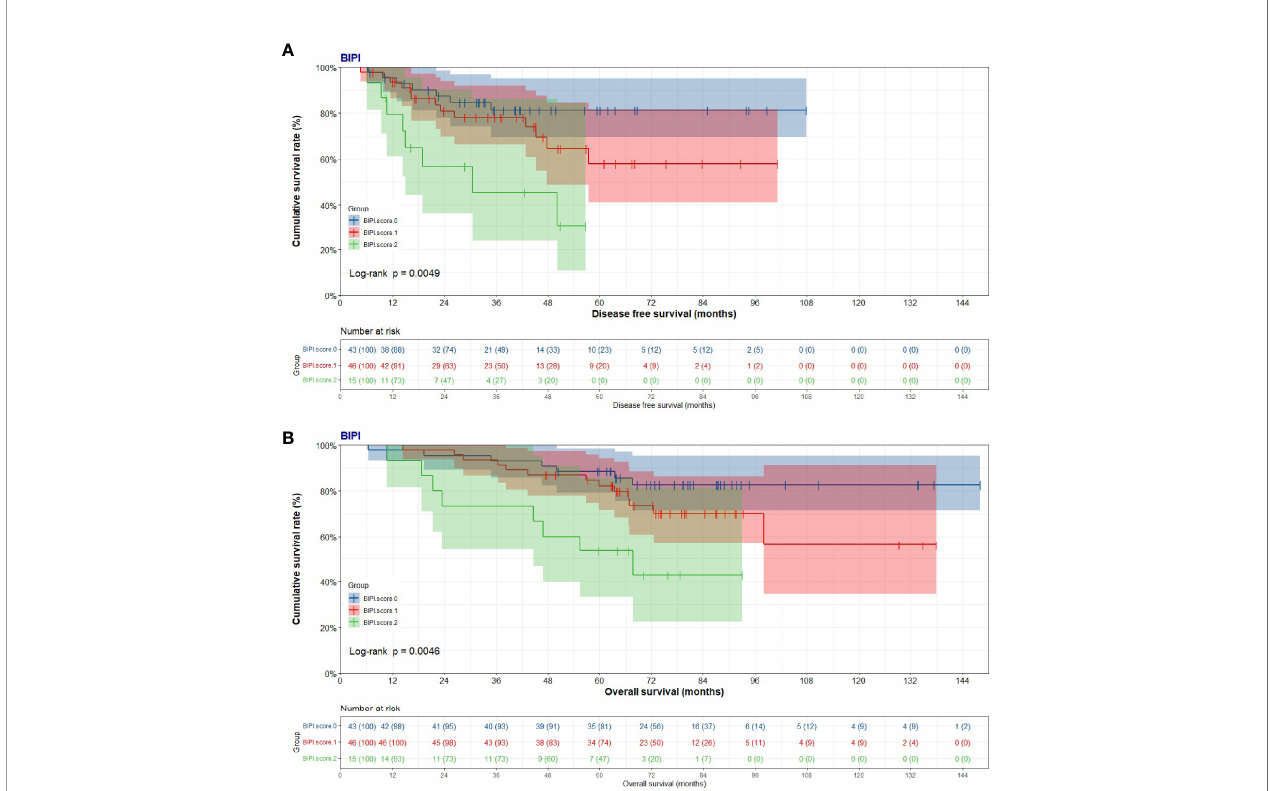
FIGURE 1 | Kaplan – Meier curves for disease-free survival (DFS) and overall survival (OS). (A) Kaplan – Meier curves for DFS for breast immune prognostic index (BIPI). (B) Kaplan – Meier curves for OS for breast immune prognostic index (BIPI).